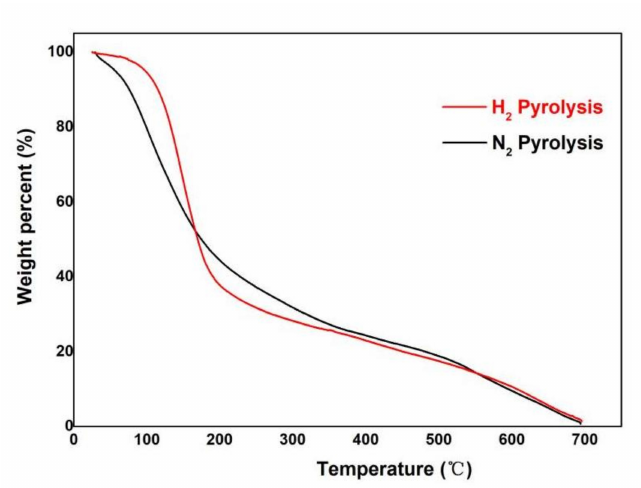
Figure 3. TG of pyrolysis oil under different atmospheres.